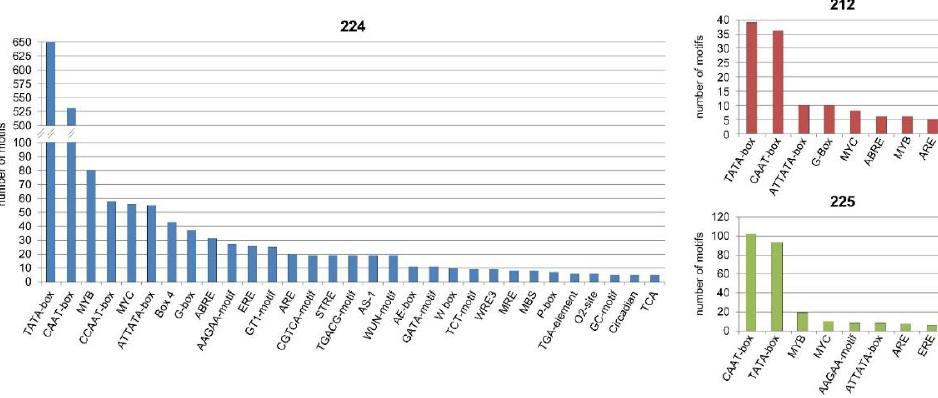
Figure 6. Promoters analysis - occurrence of the different types of motifs in upstream promoter regions of the differentially expressed genes.